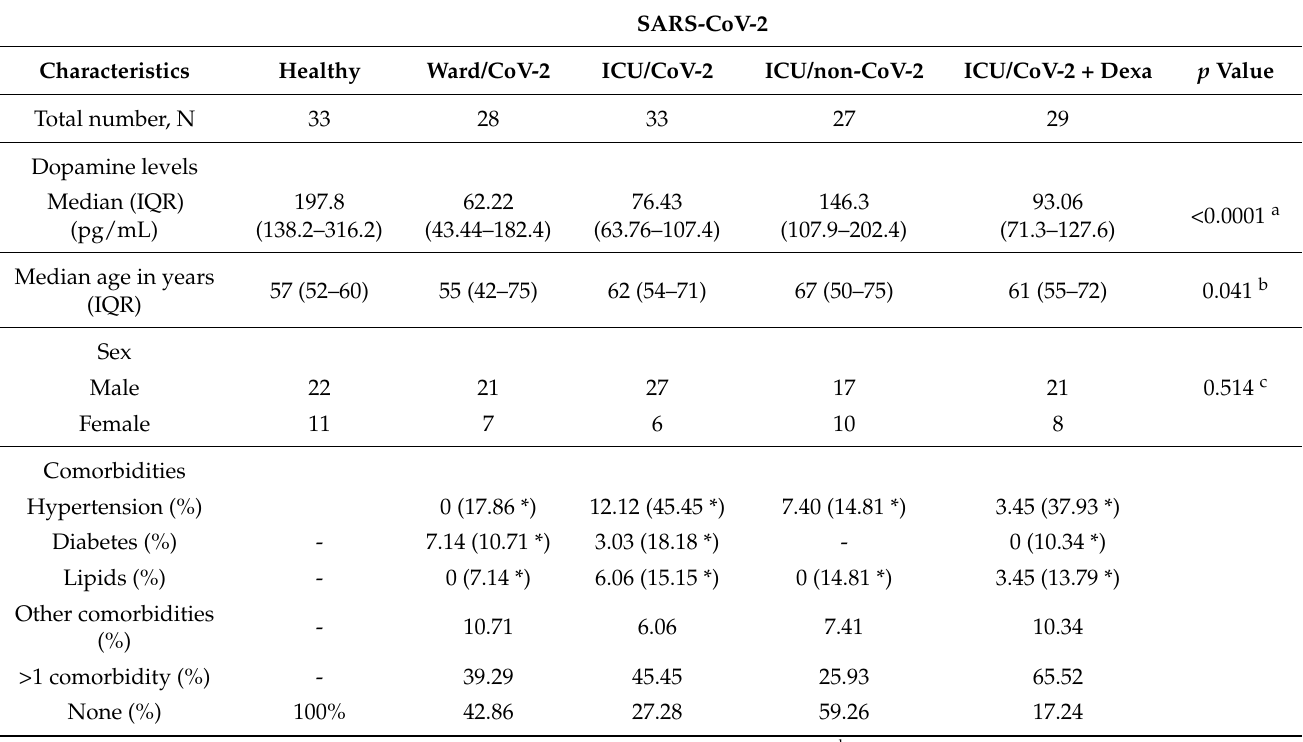
Table 4. Demographic data and in-hospital measured laboratory parameters of subjects whose sera were used.